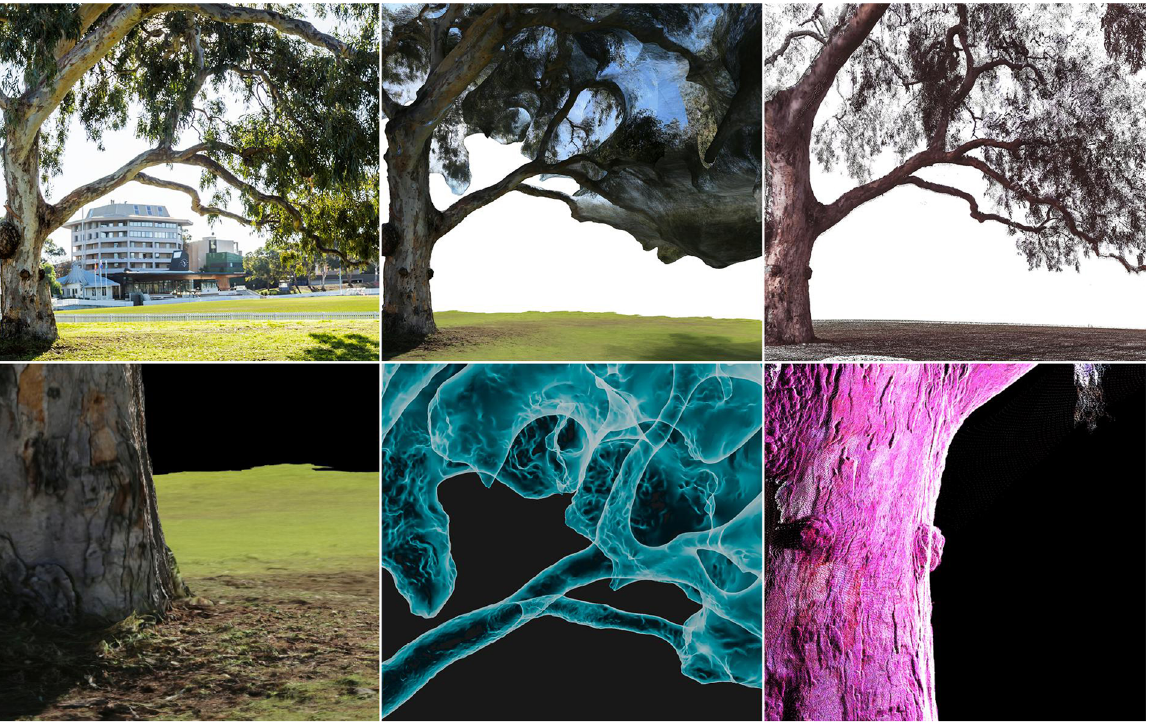
Fig. 7 A remnant river red gum captured by photography, photogrammetry and LiDAR. Top left: photograph. Top middle: photogrammetry. Top right: LiDAR. Bottom left: detail of the photogrammetry texture. Bottom middle: detail of the photogrammetry mesh. Bottom right: detail of the lidar points (Source: the